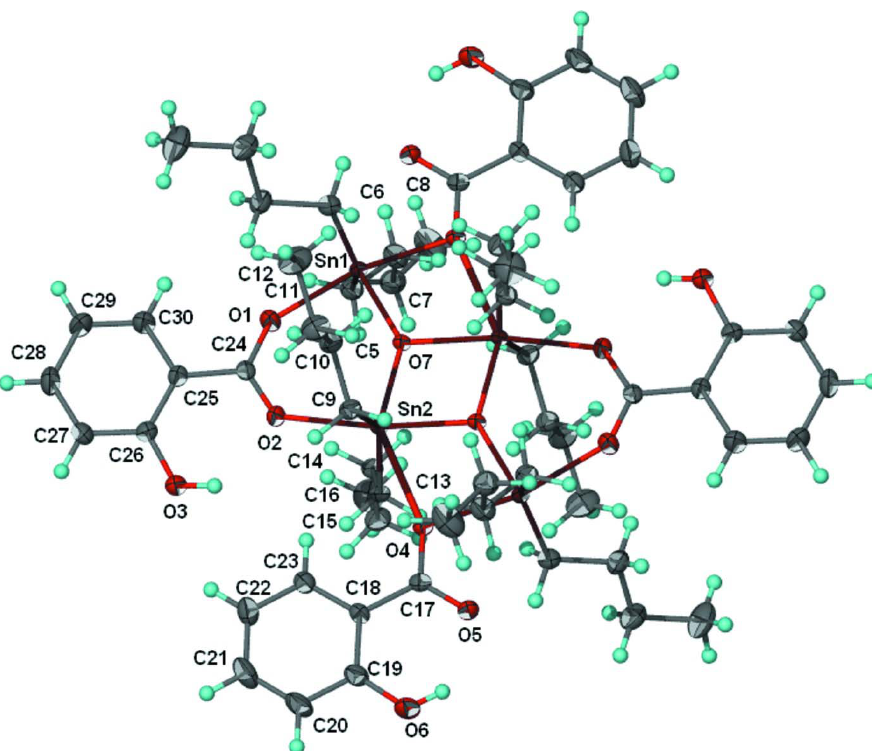
(C H ) (C H O ) O] at the 70% probability level. Hydrogen atoms are 2 4 9 4 7 5 3 2 2